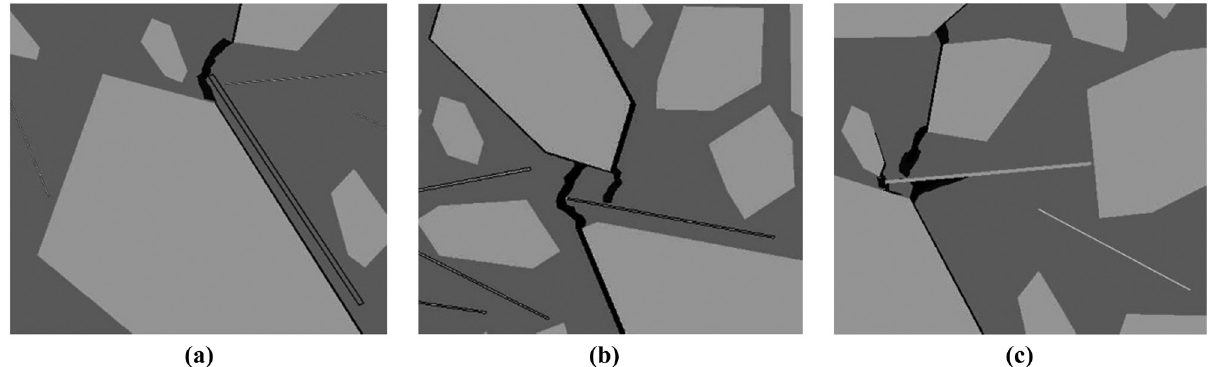
Figure 11: Enlarged views of the local cracks. ( a ) crack bypassing the steel fi ber, ( b ) crack terminating at the steel fi ber, and ( c ) crack spanning the steel fi ber.